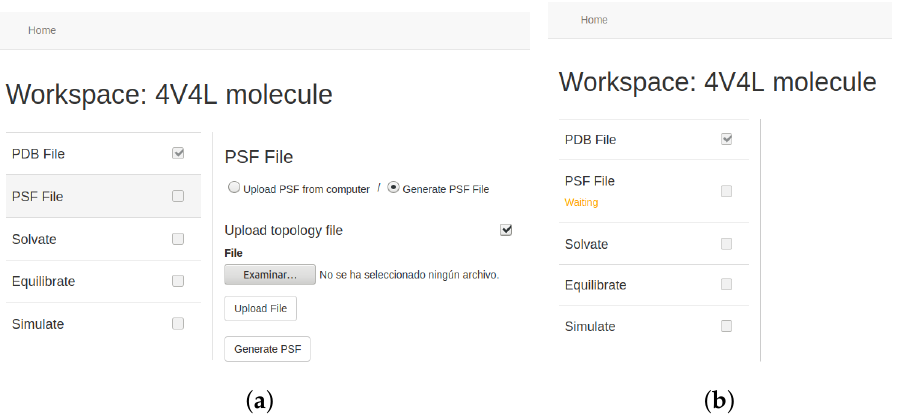
Figure 9. PSF creation stage: ( a ) shows the detail of the tool with the configuration options. Users can choose default topologies or upload a custom topology file. ( b ) The tool’s interface when the execution of this step is in progress.